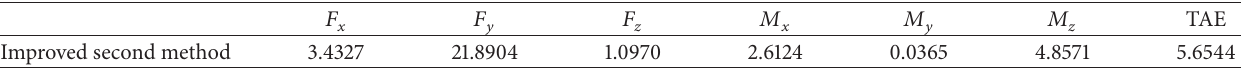
Figure 4: Comparison of actual and measured displacements in 𝑧 -direction of first point on the plate. Table 5: Average error in dB calculated in the frequency range of 0–200